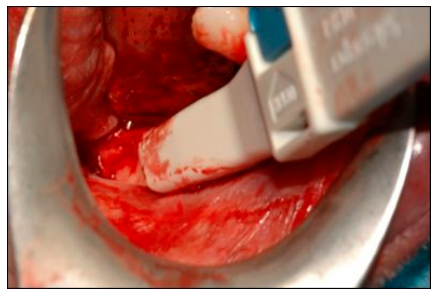
Figure 5. A bone scraper was used to collect autologous bone tissue.